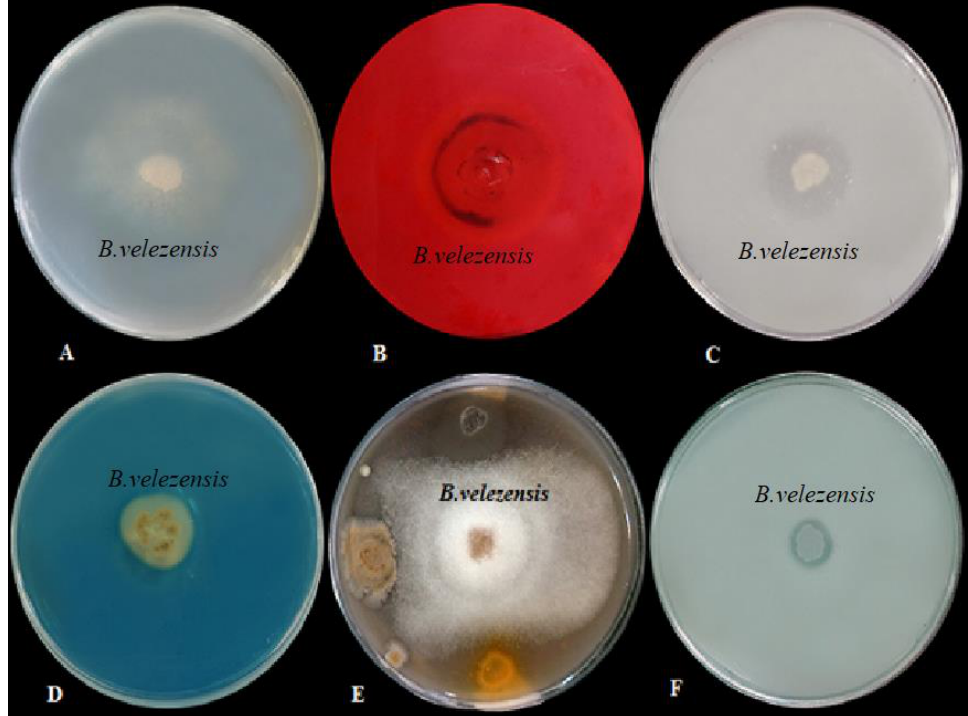
Figure 2. ( A ): Production of lipase; ( B ): Production of cellulose; ( C ): Production of protease en- zyme; ( D ): Siderophore production; ( E ); Inhibition zone of Phytophthora drechsleri ; ( F ): Phosphate solubilization activity.